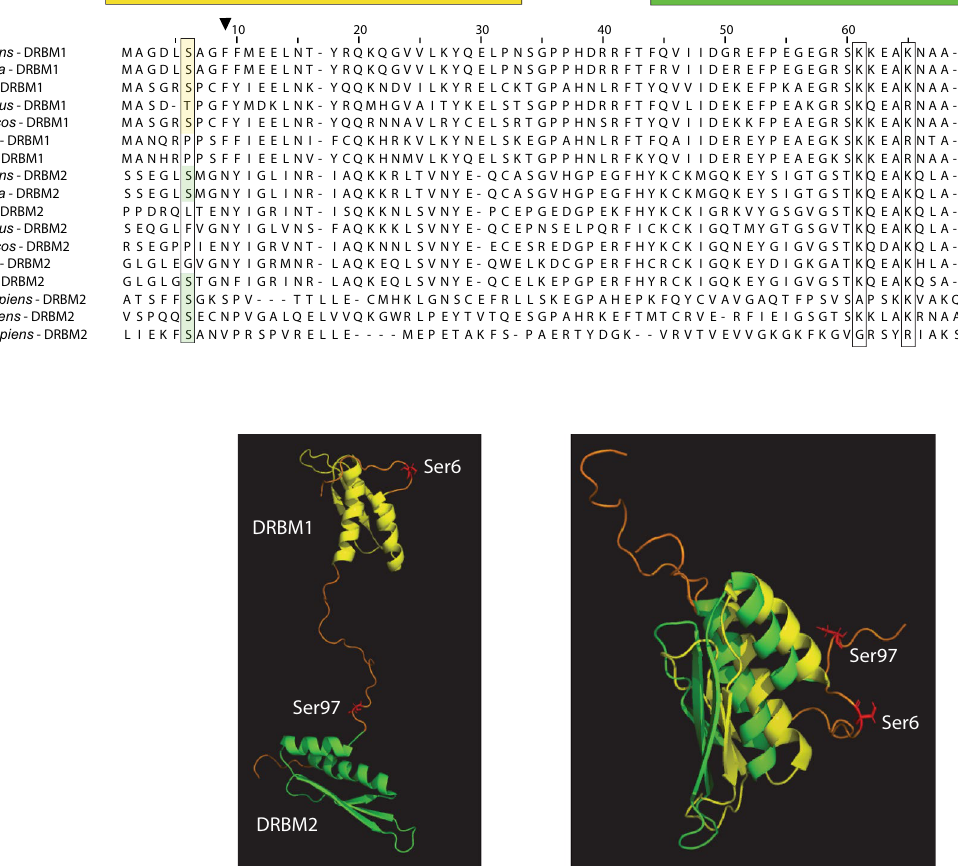
Figure 1. PKR serine 6 can be phosphorylated in TMEV-infected cells. ( a ) Phosphorylation sites identified after PKR immunoprecipitation from HeLa (PKR WT ) or from PKR-KO cells transduced to express a kinase- dead PKR mutant (PKR K296R ), thus deficient for autophosphorylation. Phosphorylated PKR peptides were identified in mock-infected cells and in cells infected with the L M60V TMEV mutant. The PSMs (peptide spectrum match) ratio of phosphorylated on total corresponding peptides are shown for the detected phospho- peptides. ( b ) Amino acid sequence alignment of the first and second dsRNA binding motifs (DRBMs—yellow and green frames) from the indicated species. ( c ) Conserved position of Ser6 and Ser97 relative to DRBMs. The DRBM1 and 2 are shown in yellow and green, respectively. Ser6 and Ser97 are shown in red and labeled in the unstructured regions preceding the DRBMs. On the right a merged picture was generated by superimposing the two DRBMs and the surrounding regions (NMR structure of PKR 8 , PDB code 1QU6 ). Images were generated using the PyMOL molecular Graphic system, Version 2.1, Schrödinger,